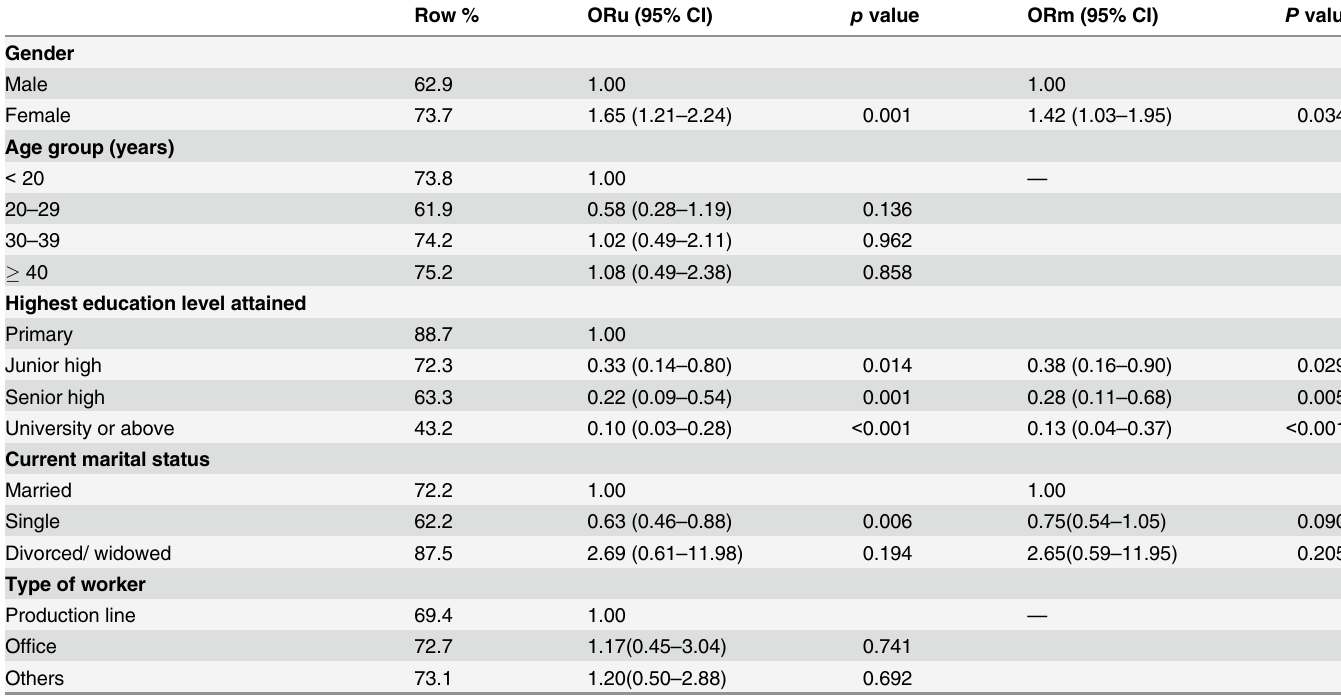
Table 2. Associations between background factors and “ a very low level of physical activity ” (i.e. having (cid:1) 30 minutes of moderate or vigorous physical activity in the last week). Row %